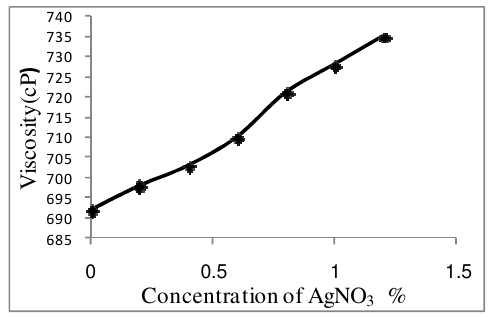
Fig. 4. Effect the (AgNO